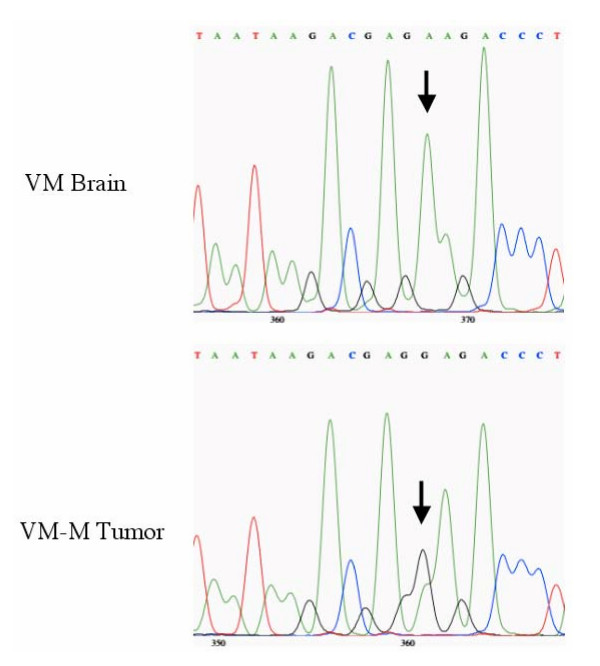
Heteroplasmy in the metastatic VM-M tumor cell line. Mitochondrial 16srRNA revealed a heteroplasmic mutation at position 2159 of an A to G transition. The three VM brain mitochondrial populations (LM, HM, and FM) displayed the same chromotagraph profile. The same level of heteroplasmy was observed in duplicate independent samples for the VM-M cell line. Arrow indicates heteroplasmic nucleotide at position 2159 compared to control.